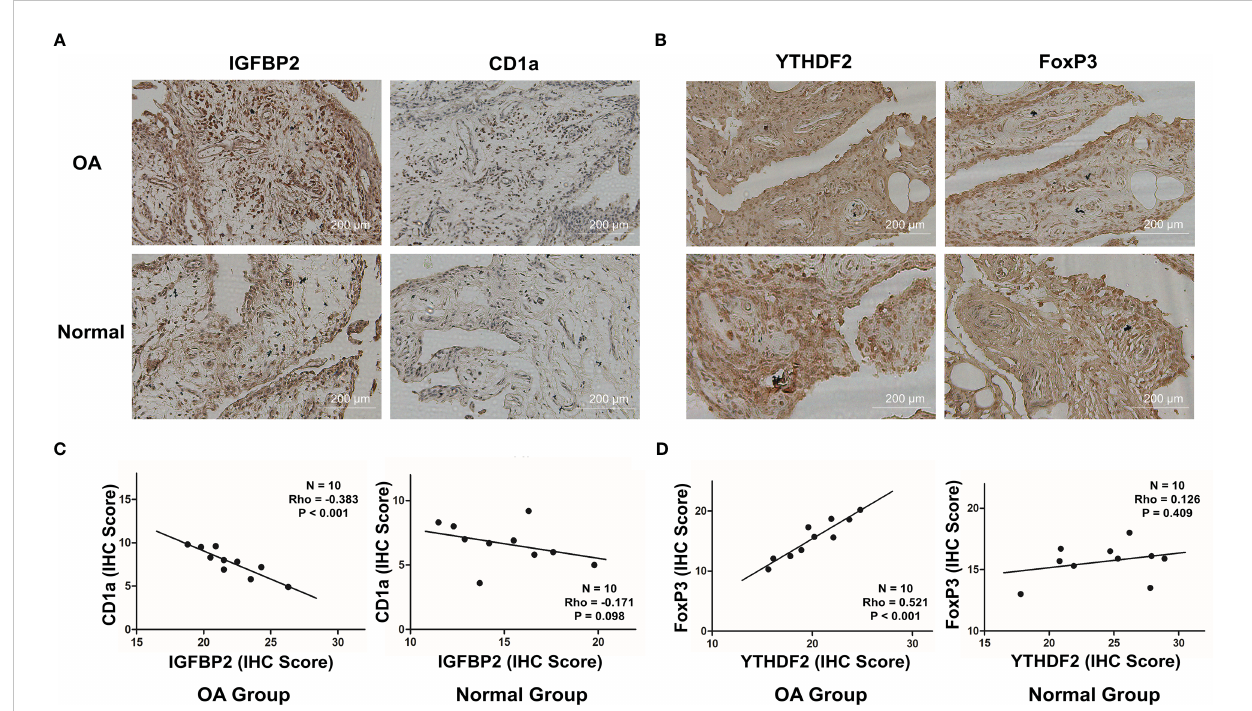
FIGURE 5 Correlations between the expression of IGFBP2 and DCs marker CD1a, YTHDF2 and Treg marker FOXP3 in OA and normal tissues. (A) Representative images for the IHC staining of IGFBP2 and CD1a in OA and normal tissues (n = 10). (B) Representative images for the IHC staining of YTHDF2 and FOXP3 in OA and normal tissues (n = 10). (C) Relation between protein levels of IGFBP2 and CD1a in OA and normal tissues via Spearman correlation. (D) Relation between protein levels of YTHDF2 and FOXP3 in OA and normal tissues via Spearman